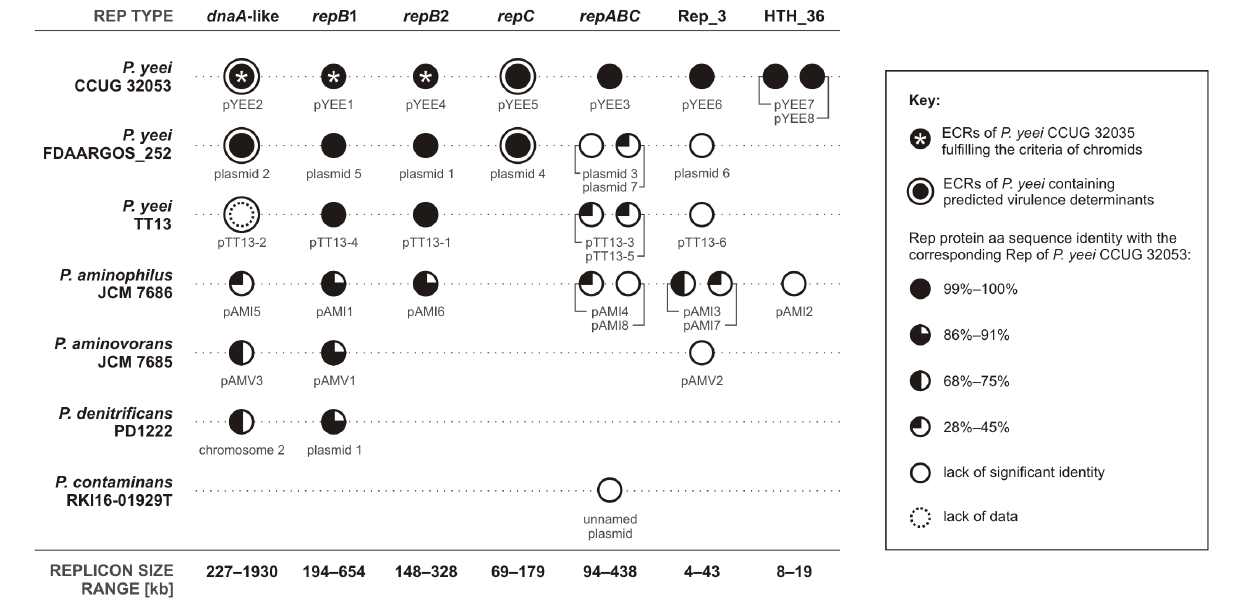
FIGURE 3 | Distribution of conserved REP regions within ECRs of complete Paracoccus spp. genomes. [The sequence of pTT13-2 of P. yeei strain TT13 (a dnaA -like replicon type in this figure) (acc. no. NZ_CP024424) contains neither a gene encoding a DnaA-like initiator nor genes encoding any other recognizable Rep proteins, which suggests that the sequence might be incomplete. Based on the high sequence similarity and conservation of gene synteny with dnaA -like replicons of the two other P. yeei strains as well as the presence of a PAR region characteristic of dnaA -like replicons, pTT13-2 has been included in the dnaA -like replicon group for this comparative